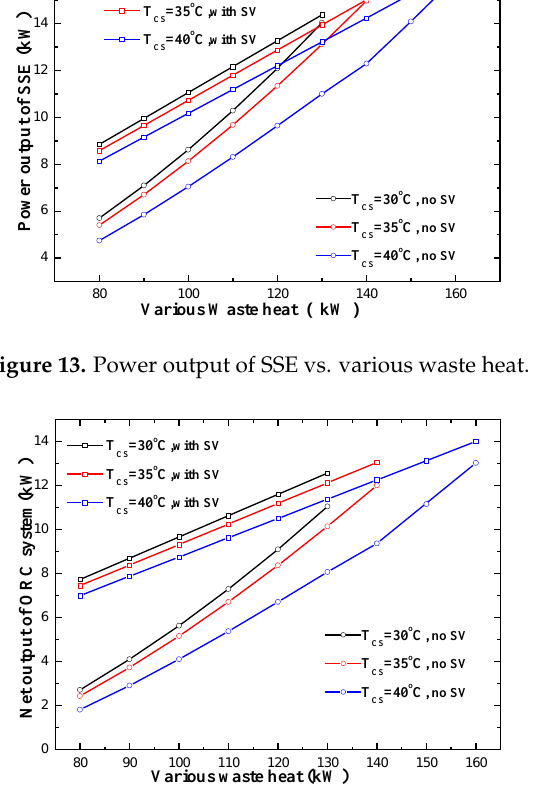
Figure 14. Net power output of the ORC system vs. various waste heat.